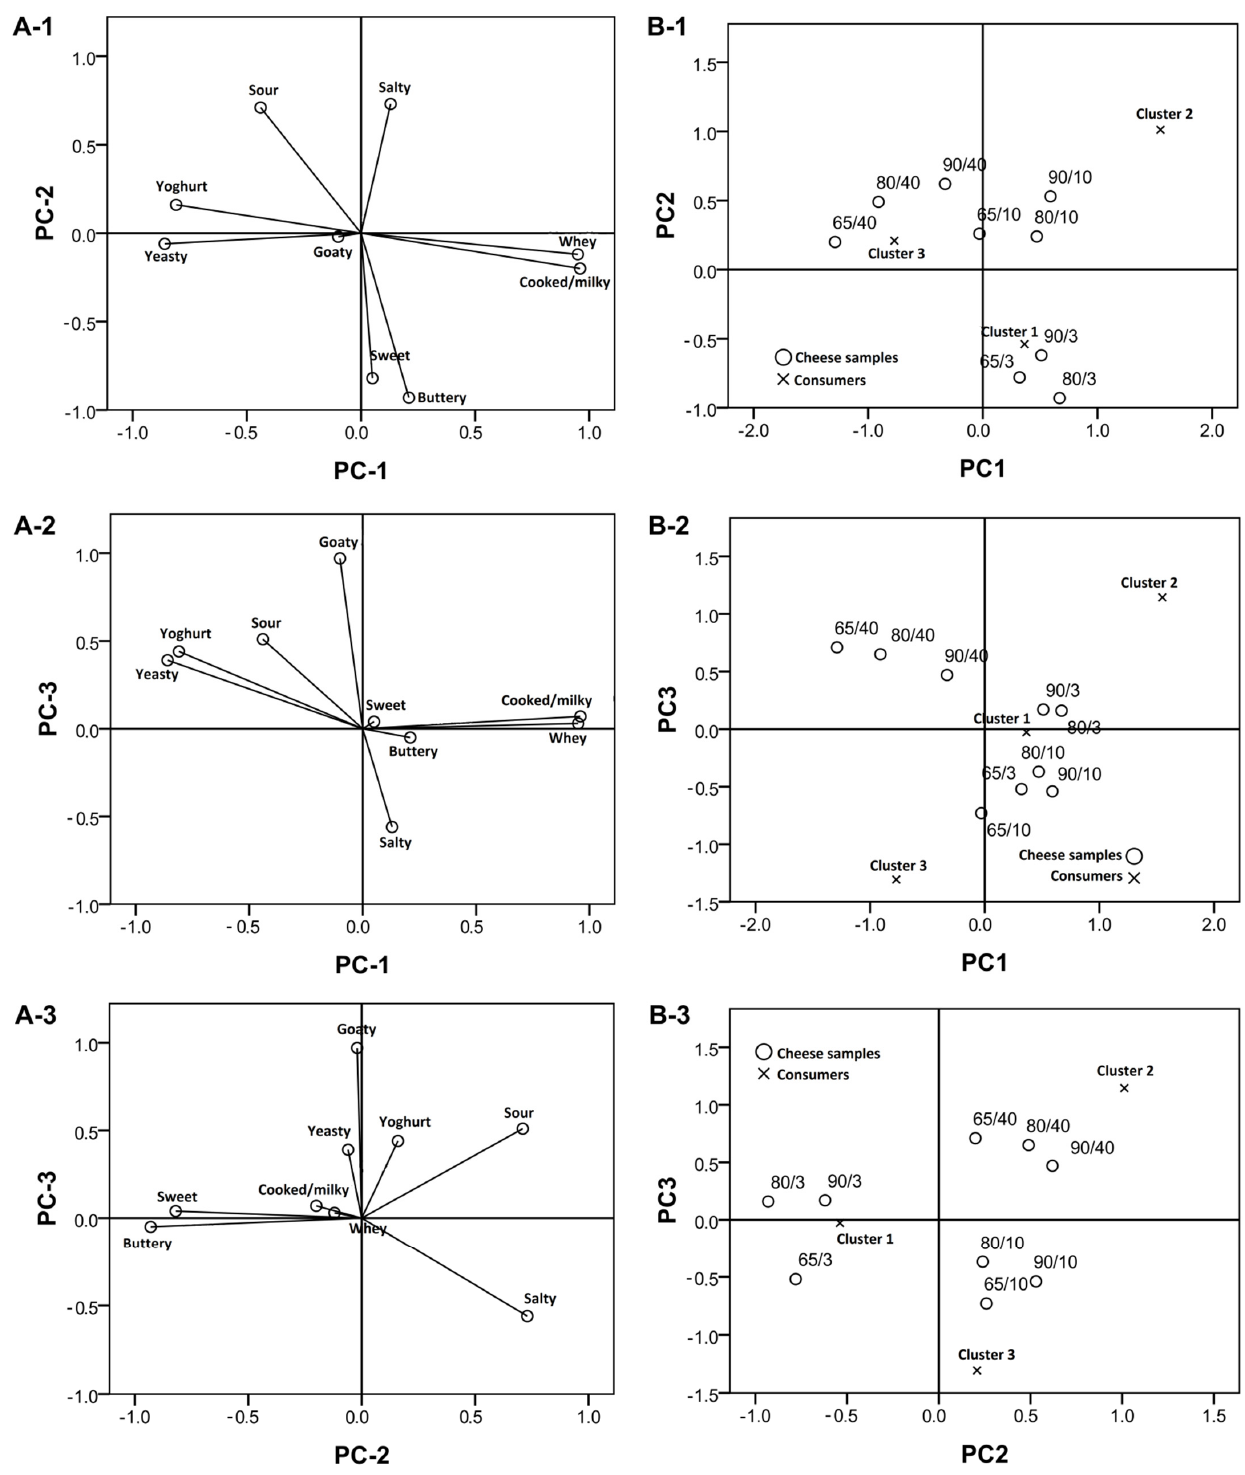
Figure 1. Attribute loadings ( A-1 – A-3 ) and cheese scores/clusters ( B-1 – B-3 ). The first three principal components obtained by the generalized Procrustes analysis on descriptive data (8 assessors/2 replications) of goat cheeses produced from milk heated to 65 °C/30 min at the early (3 days), mid (10 days) and late (40 days) stage of ripening (65/3, 65/10 and 65/40, respectively), milk heated to 80 °C/5 min at the early, mid and late stage of ripening (80/3, 80/10 and 80/40, respectively) and milk heated to 90 °C/5 min, at the early, mid and late stage of ripening (90/3, 90/10 and 90/40, respectively).